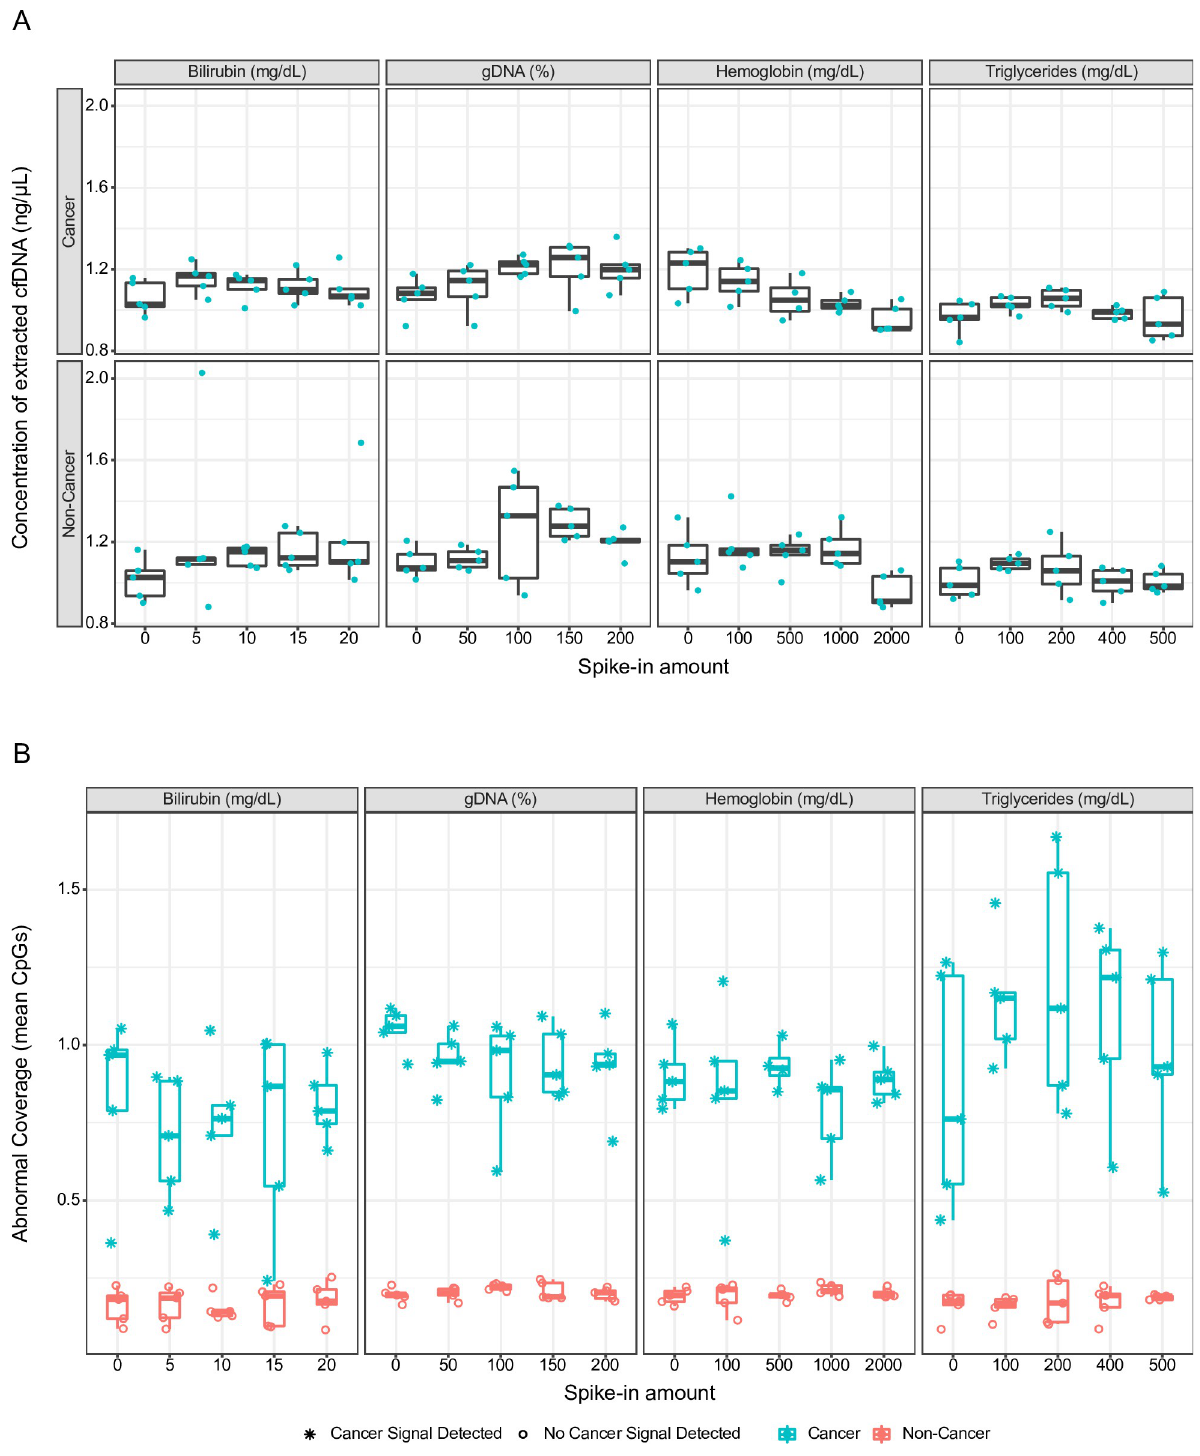
Fig 7. Effect of various concentrations of 4 potential interferents on (A) concentration of extracted cell-free DNA (cfDNA) and (B) abnormal coverage. Prior to cfDNA extraction, non-cancer plasma samples and cancer admixtures were spiked with bilirubin (0–20 mg/dL), high-molecular- weight genomic DNA (0–200% of total cfDNA extracted from unspiked samples), hemoglobin (0–2000 mg/dL), and triglycerides (0–500 mg/dL). Cancer admixtures were generated by adding abnormally methylated DNA from human HCT116 DKO cells to non-cancer plasma samples. Teal circles in Panel A represent samples. Boxes indicate 25th and 75th percentiles and the line inside corresponds to the median. Whiskers extend to